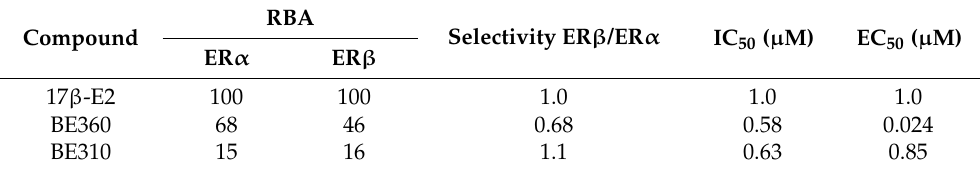
Table 3. The binding affinity of carborane derivatives for human recombinant ER and their effect on MCF-7 regarding cell